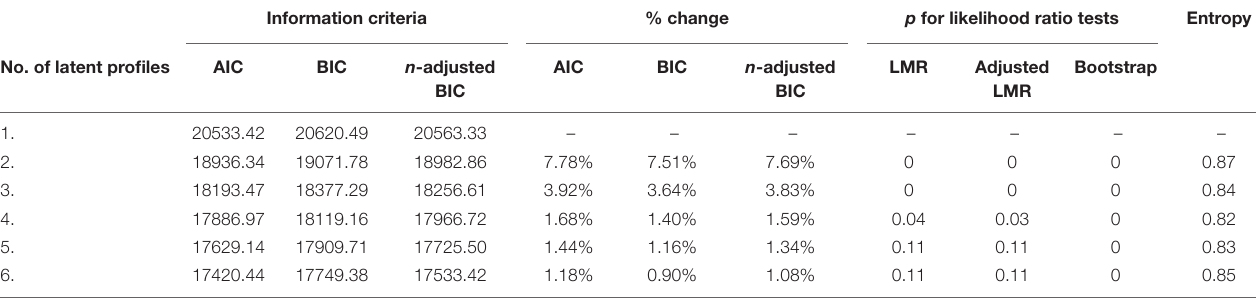
TABLE 10 | LPA model fit indicators (secondary schools).